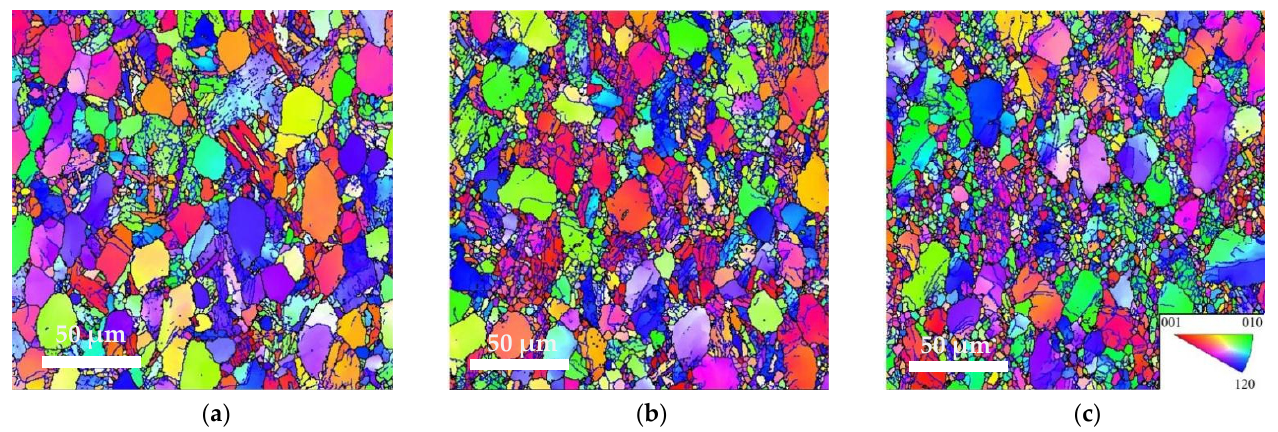
Figure 5. IPFs of specimens without pre ‐ deformation at different true strains: ( a ) 0.3; ( b ) 0.5; and ( c ) 0.7.